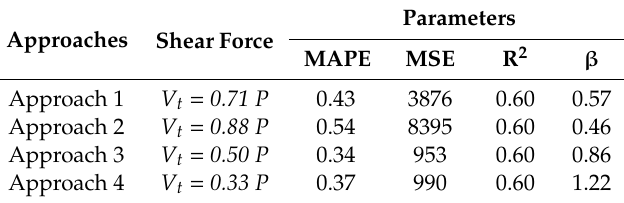
Table 3. Statistical error indicators for the di ff erent approaches applied to the un-strengthened walls. Approaches